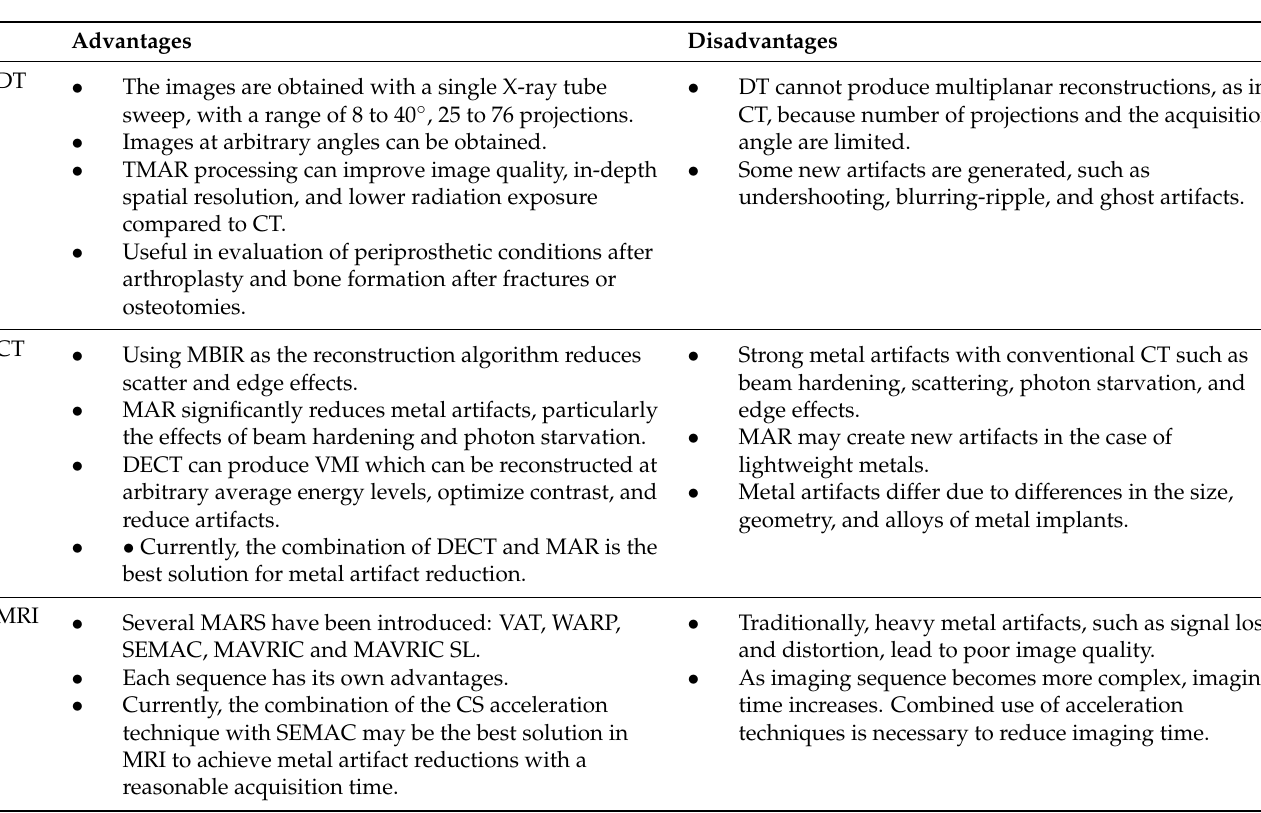
Table 4. Characteristics of modalities presented in the